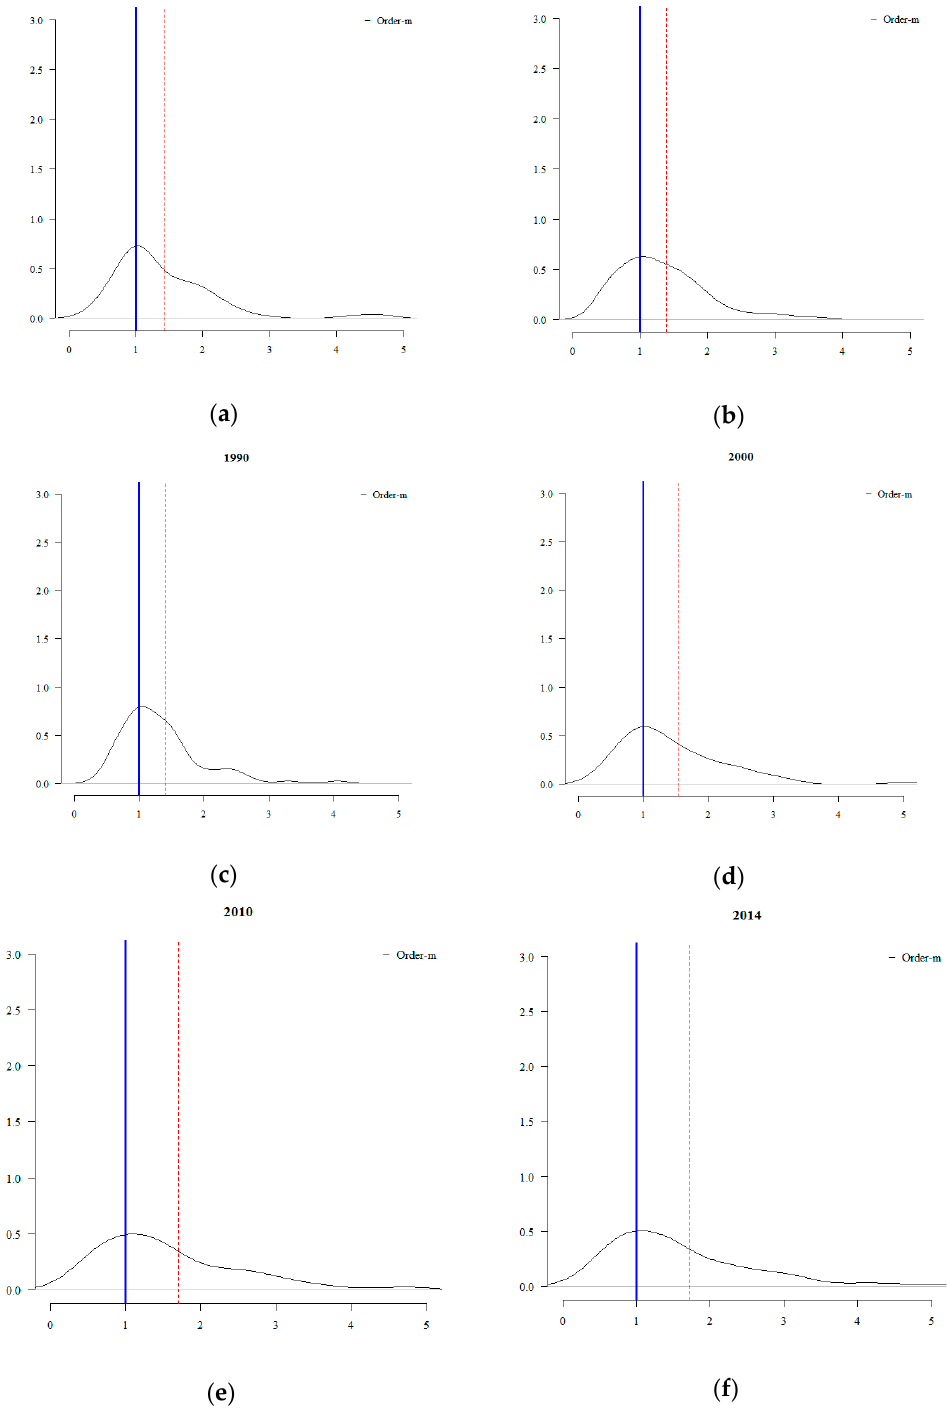
Figure 2. A diachronic representation of unconditional countries’ production efficiency levels derived from the Order-m estimator. Note: The red dotted line indicates the average Order-m value; The blue solid line indicates unity.